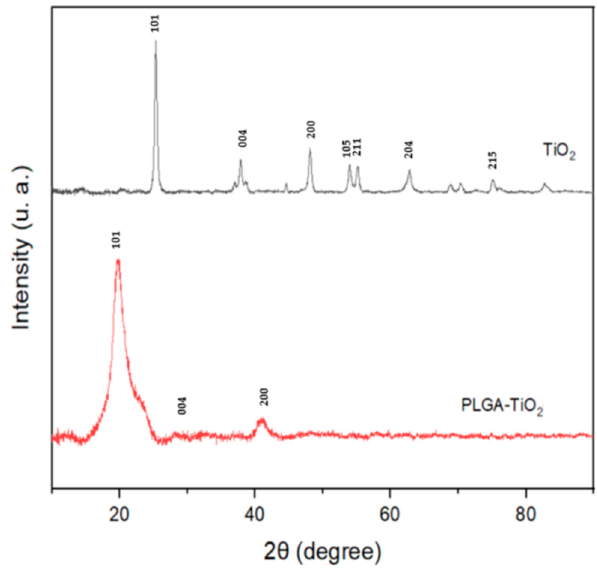
Figure 2. X-ray diffraction patterns of pure titanium dioxide (TiO 2 ) and nanocomposite (PLGA–TiO 2 ). Table 1. Comparison of the crystallinity parameters of titanium dioxide.